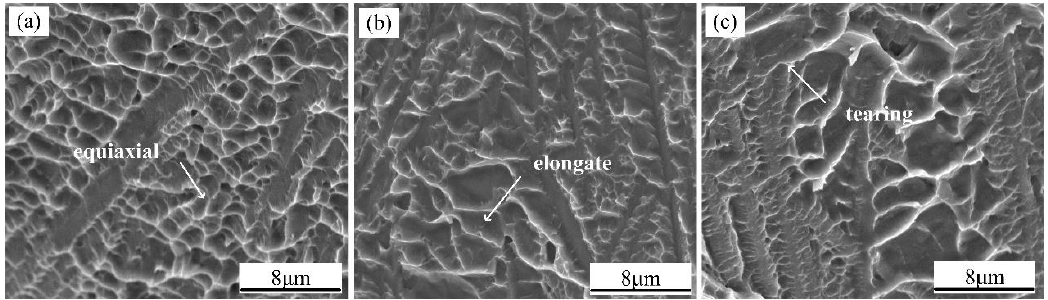
Figure 11. High-magnification SEM fractographs of the joints welded at ( a ) E = 2.2 × 10 3 J/cm; ( b ) E = 3.4 × 10 3 J/cm; and ( c ) E = 5.5 × 10 3 J/cm.